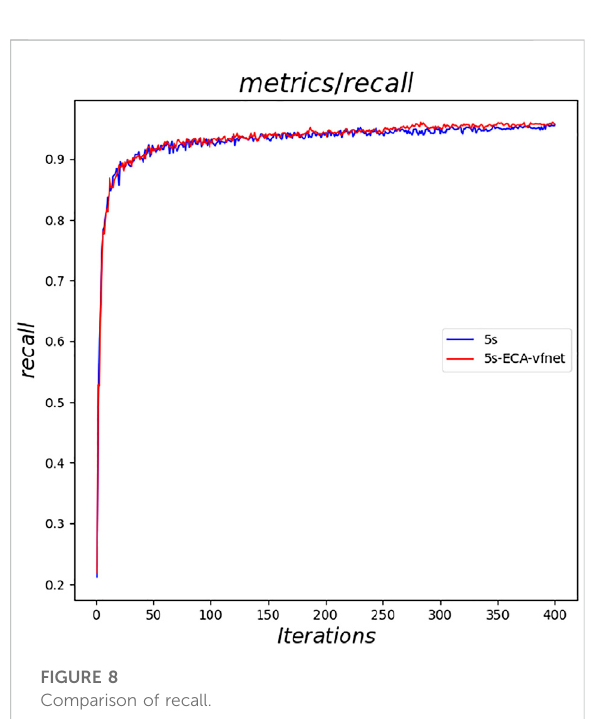
FIGURE 6 Comparison of precision.